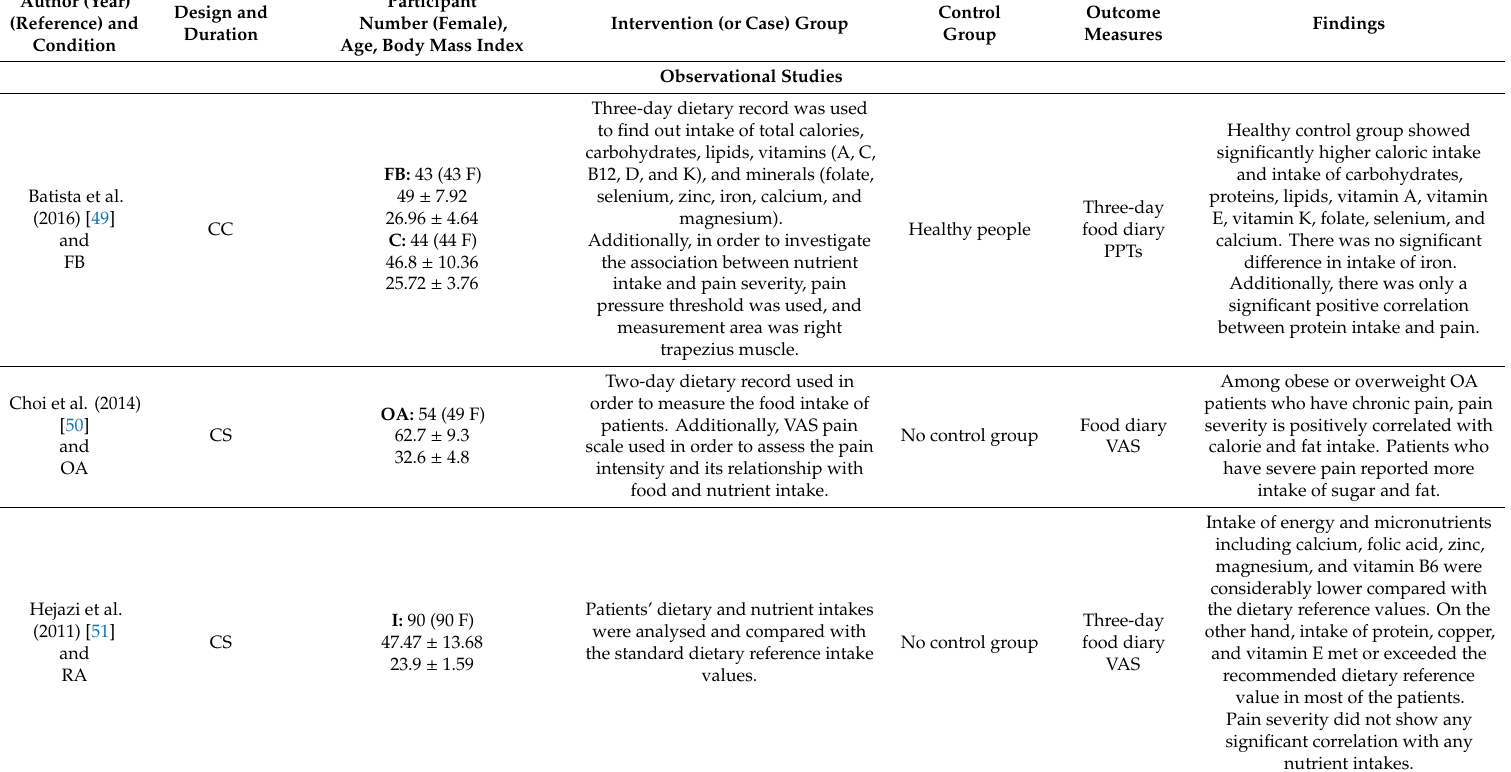
Table 1. Data extraction